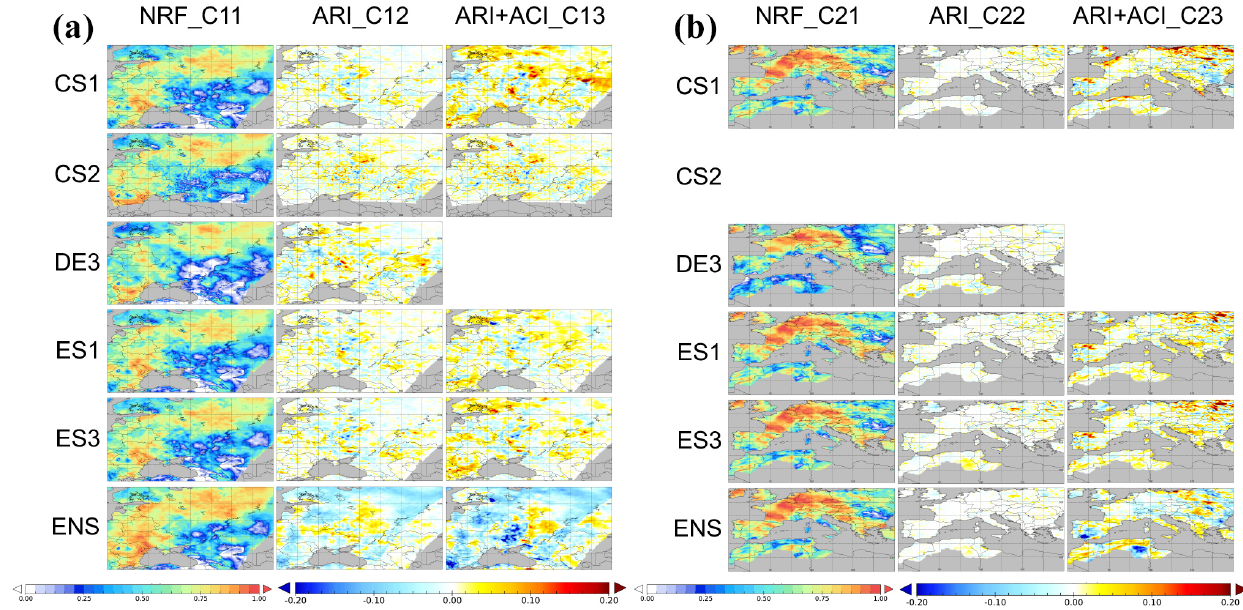
Figure 7. Time determination coefficient ( ρ 2 ) (model vs. E-OBS) of the minimum temperature (TMIN) for the fire (a) and dust (b) episodes. The first column in each panel represents the value of ρ 2 of the no radiative feedback case with respect to the E-OBS database. The center and right columns indicate the increase (red values) or decrease (blue value) in each simulation with respect to the case not including